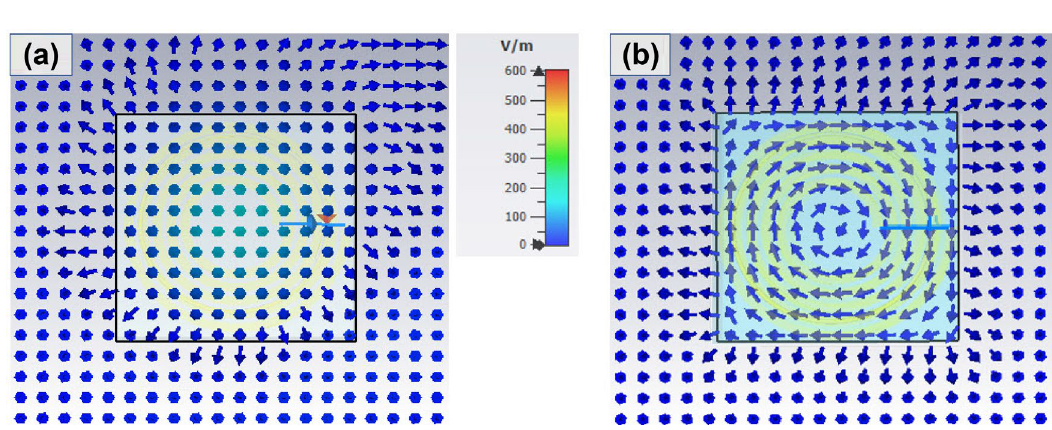
Figure 3. Electric field intensity distribution at the middle plane of (a) free space and (b) with a conducting